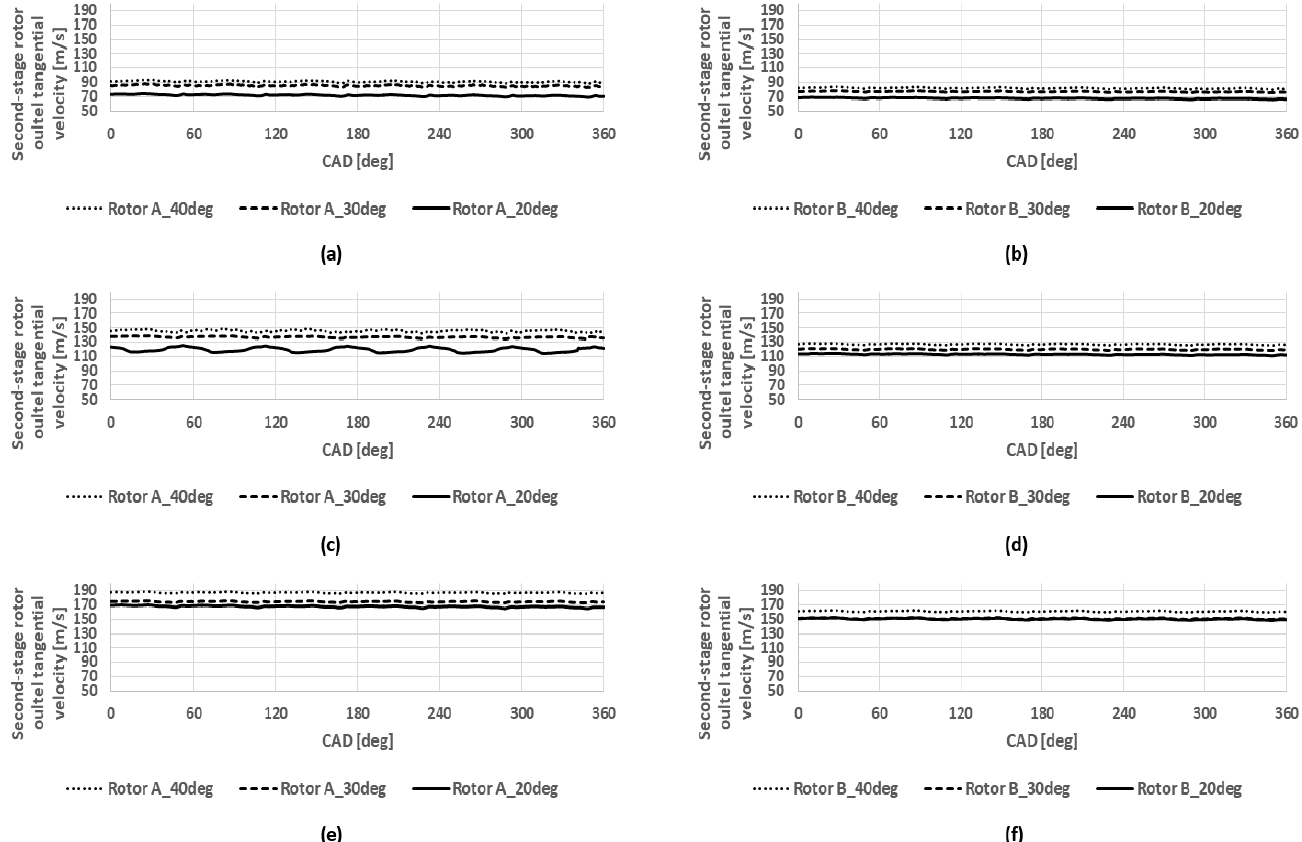
Figure 29. The velocity streamlines at the outlet from the first-stage rotor at two different turbine speeds and VTG positions for: ( a ) rotor A and ( b ) rotor B geometry.